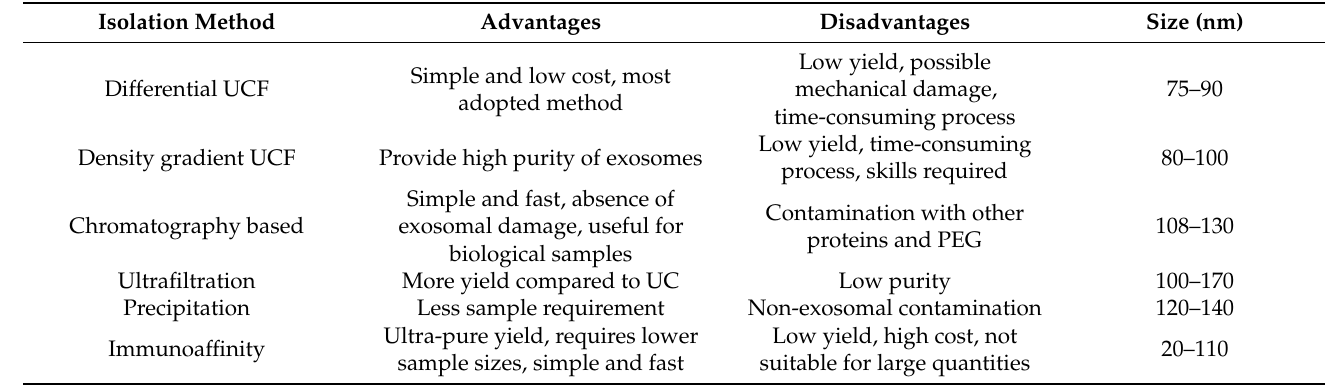
Table 3. Advantages and disadvantages of various isolation methods.